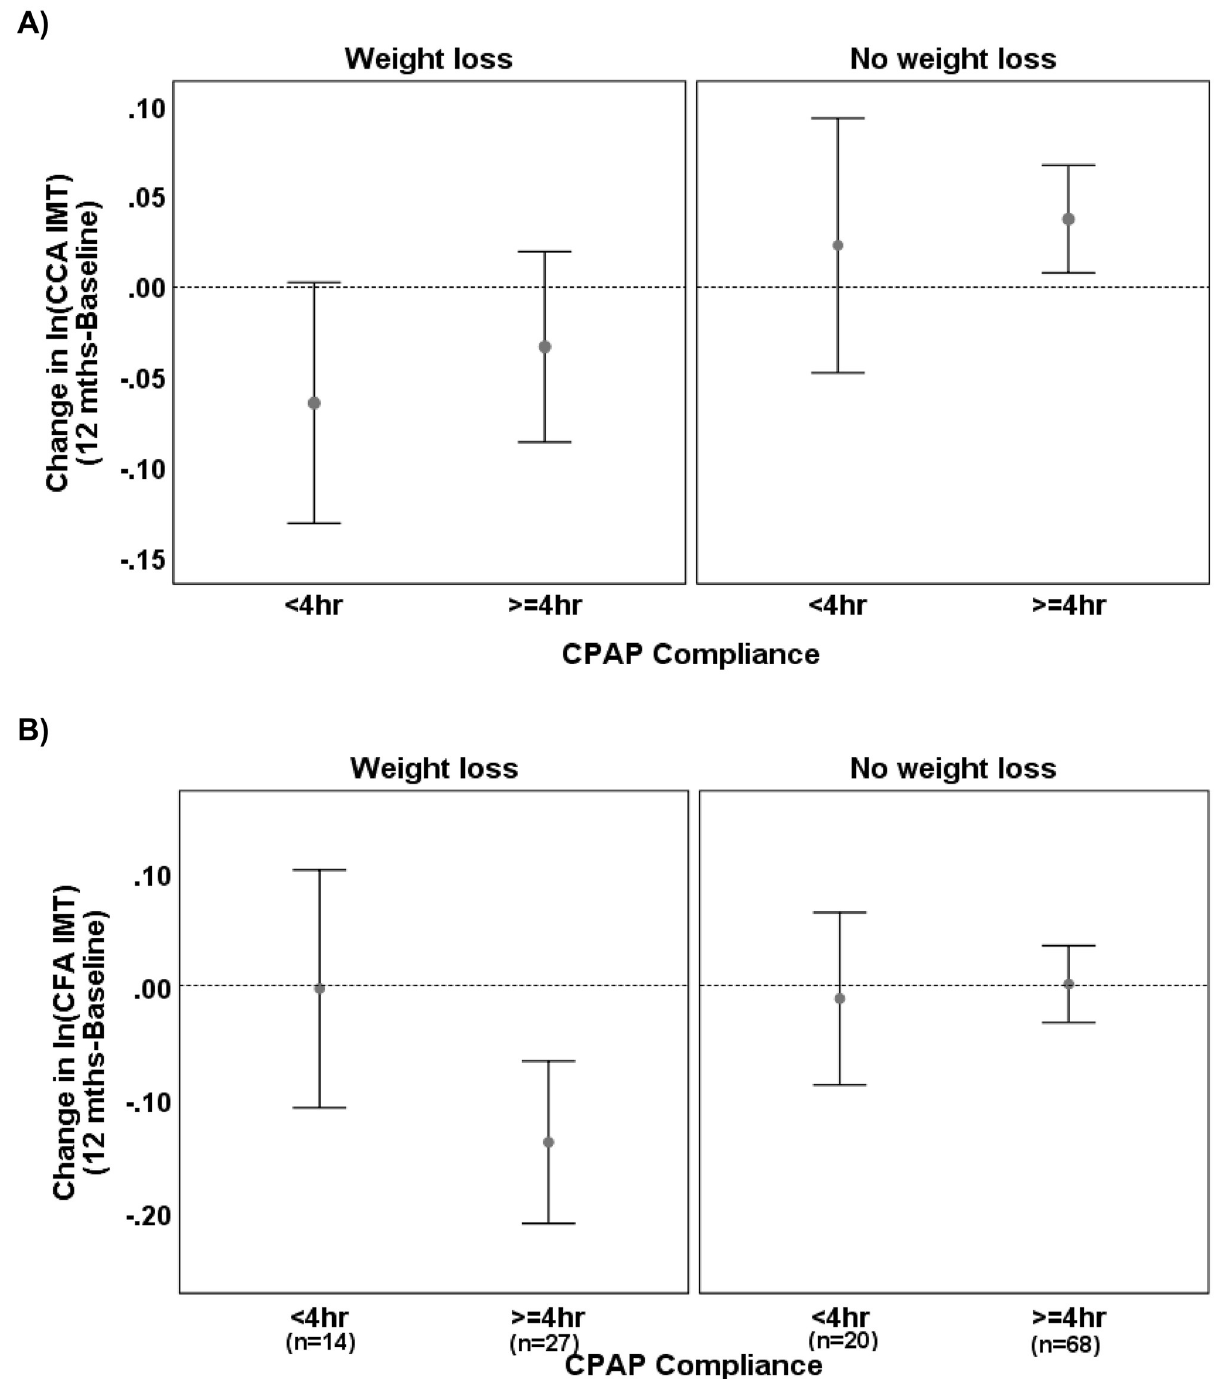
Fig 3. RFM sub-group—Effect of CPAP use on ln(CCA IMT) and on ln(CFA IMT) by weight loss status. Mean with 95%CIs showing the within participant change in ln(CCA IMT) and in ln(CFA IMT) in the RFM Sub-Group during the 12-month RFM intervention by weight loss status and CPAP use. The ln(CFA IMT) depended on both weight loss and CPAP use (p = 0.020) with those who lost weight and also used CPAP > = 4hrs/day demonstrating a 12.9% (95%CI 6.8, 18.7%, p = 0.001) reduction in CFA IMT from baseline compared to no significant change in those who gained/ maintained weight or used CPAP <